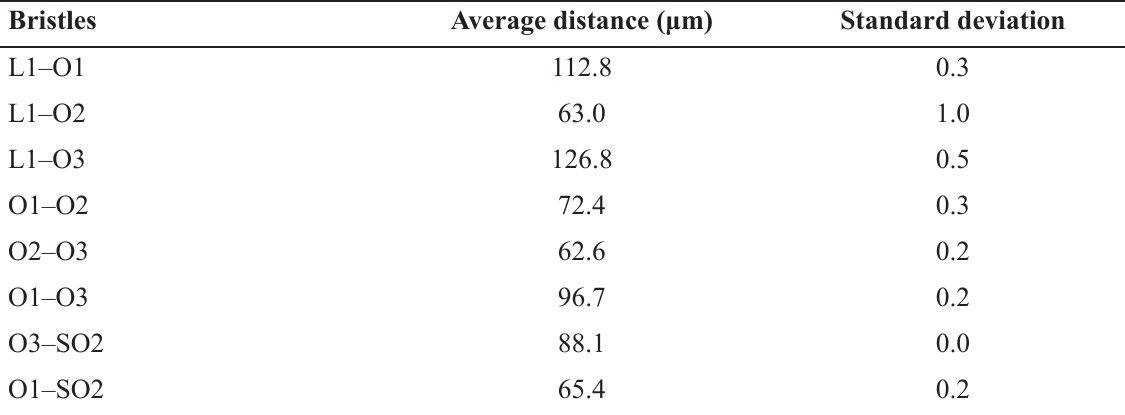
Table 6. Distance between the bristles on the head capsule of M. timandra binaludica subsp. nov.